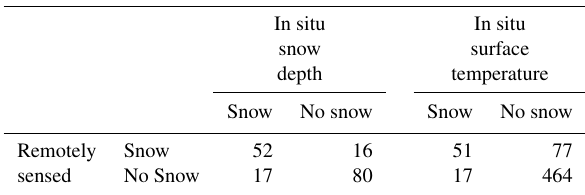
Table 5. Confusion matrices for comparison of in situ snow obser- vations provided by snow depth and surface temperature observa- tions with remotely sensed snow maps (MOD10A2 and Landsat 8 combined).